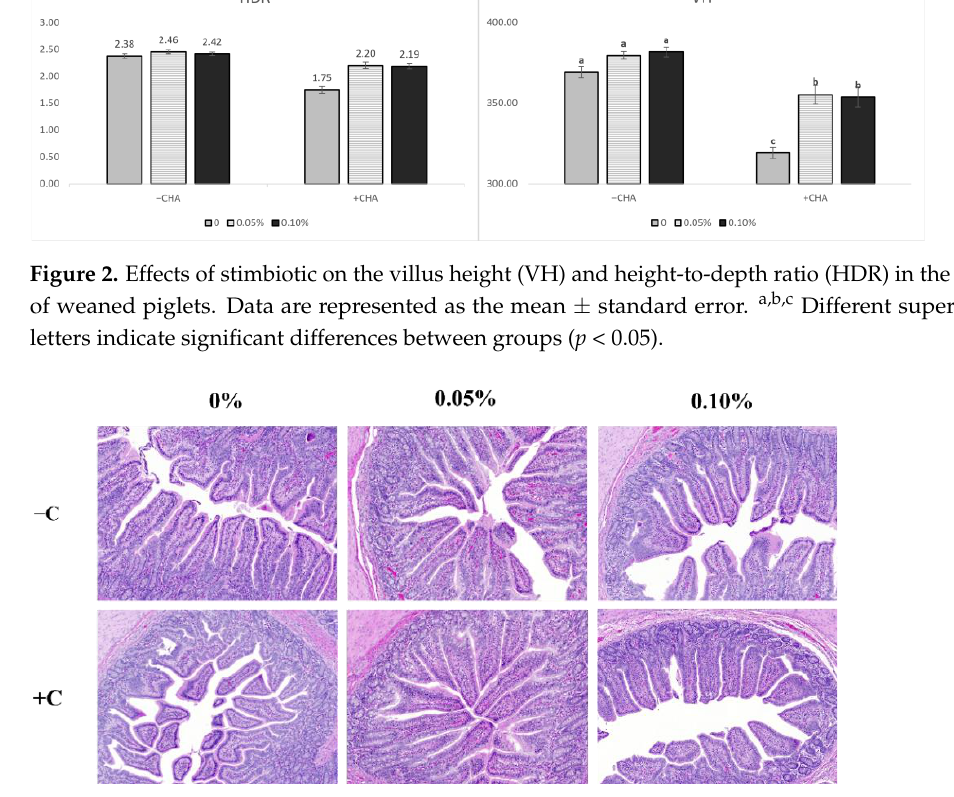
Figure 3. Histological analysis of the intestinal morphology of weaned piglets. Figures display the morphology of ileum tissue from pigs in six dietary treatments. Table 7. Effects of stimbiotic supplementations on the villus height and crypt depth of pigs chal- lenged with